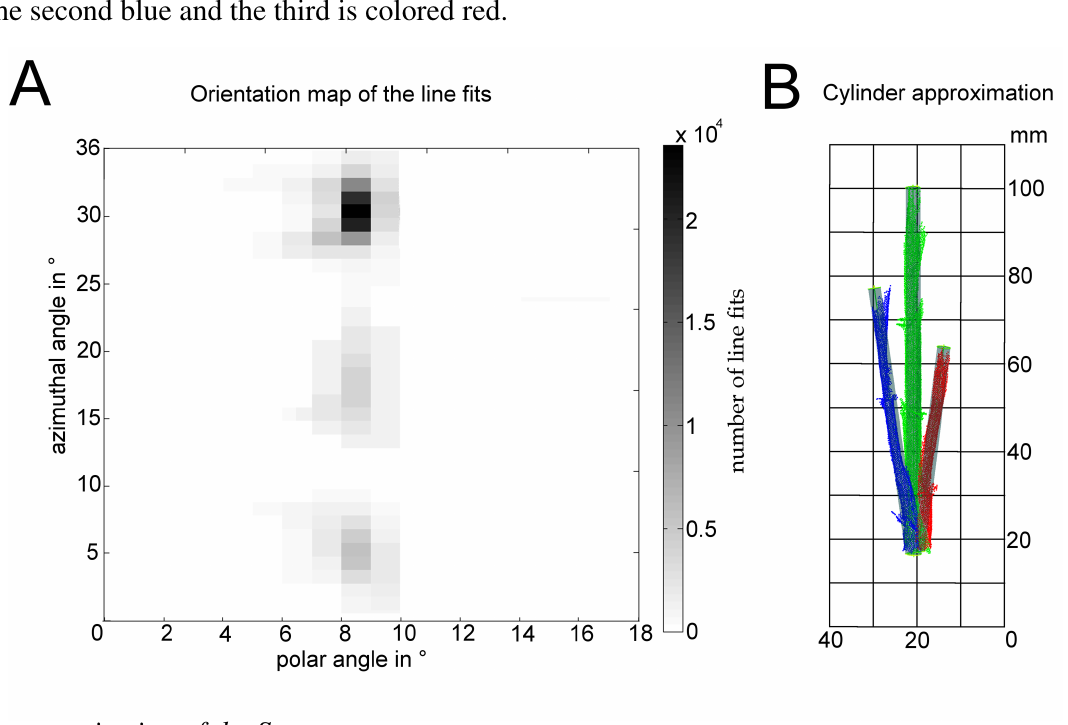
Figure 4. The result of the octant-wise line fits is a heat map showing the summarized direction vectors using a spherical representation showing three local maxima ( A ). The grayscale encodes the amount of lines with the same orientation. For every cluster, a least-squares approximation of a cylinder is calculated ( B ). The first stem is colored green, the second blue and the third is colored